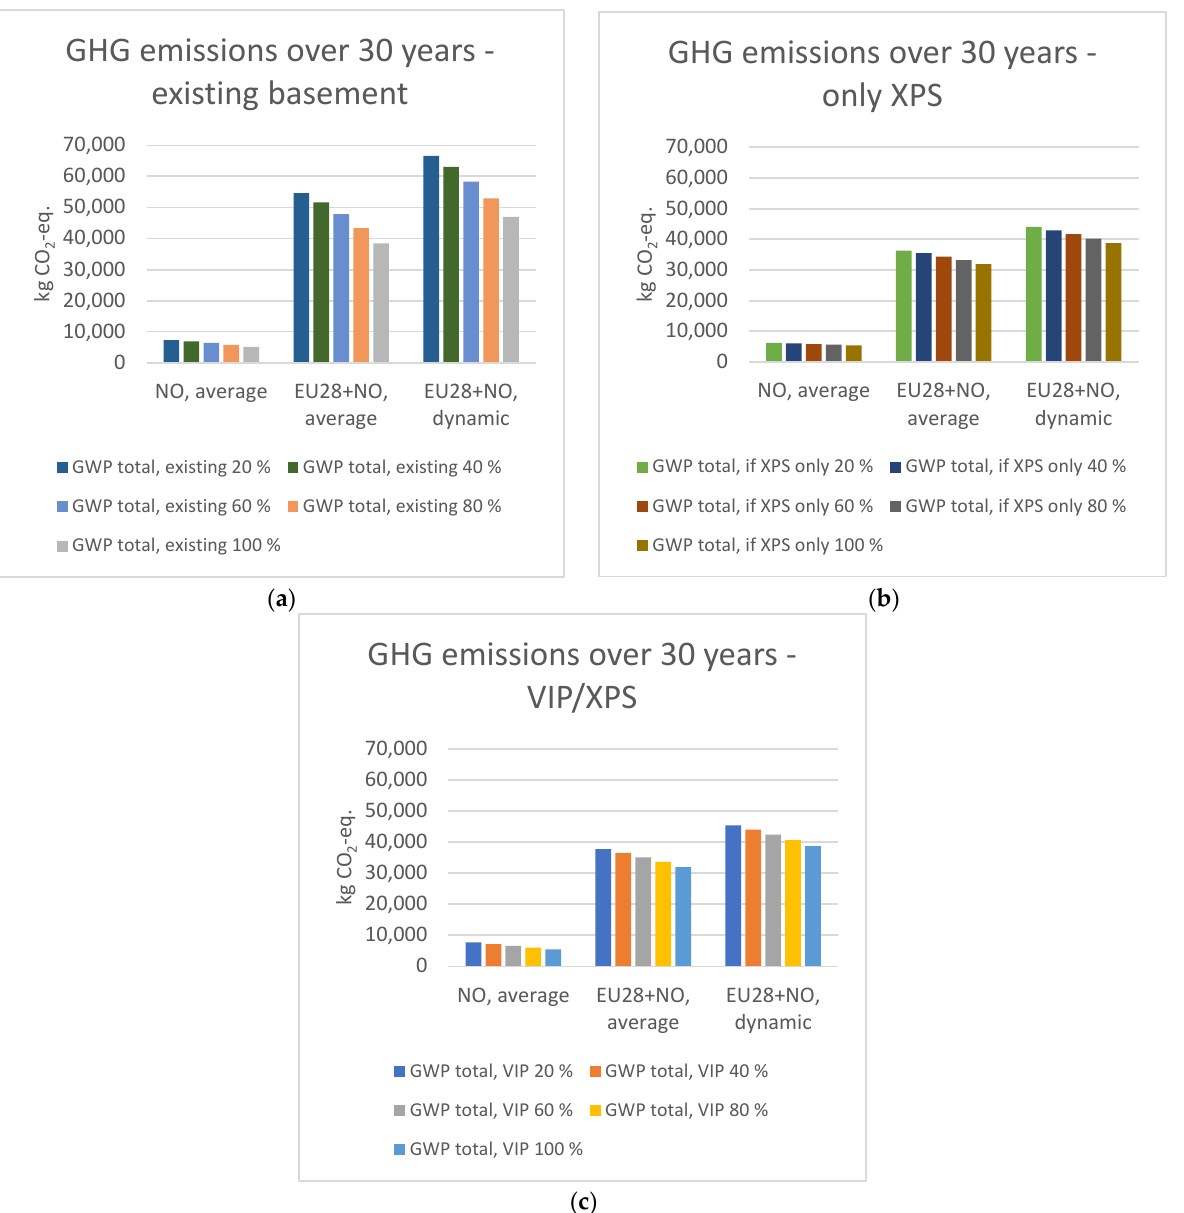
Figure 5. Accumulated GHG emissions over 30 years for three different electricity scenarios: ( a ) the existing basement; ( b ) an upgrade with only XPS; ( c ) an upgrade with superinsulation (VIP above ground and XPS below ground). Percentages indicate how much of the wall is below the ground.